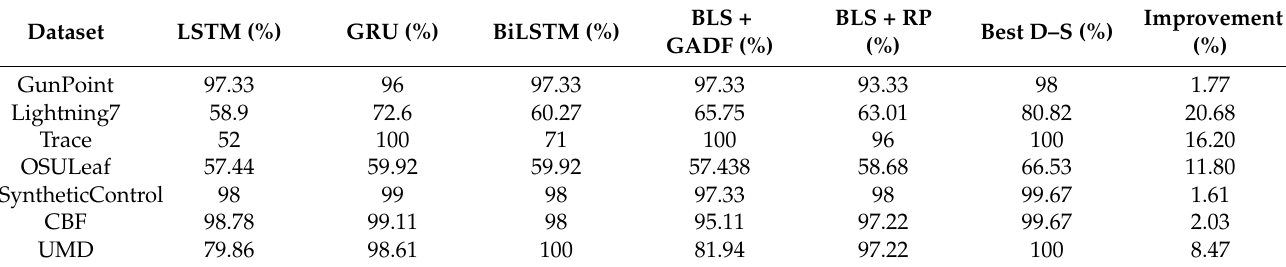
Table 4. A comparison of accuracy before and after fusion.